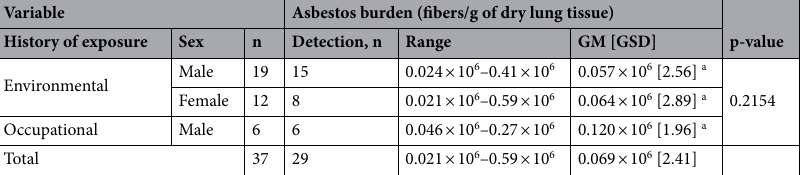
Variables Standard Variables History of exposure Environmental